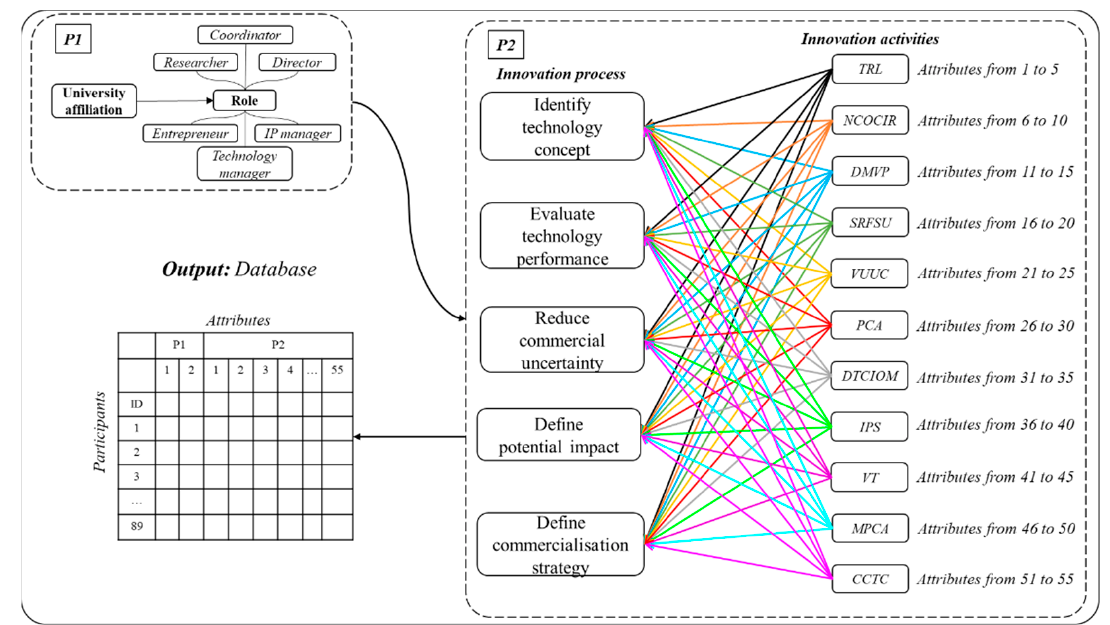
Figure 1. Survey scheme to identify mental models regarding innovation activities and POVD, acronyms can be found in Section 2.1.